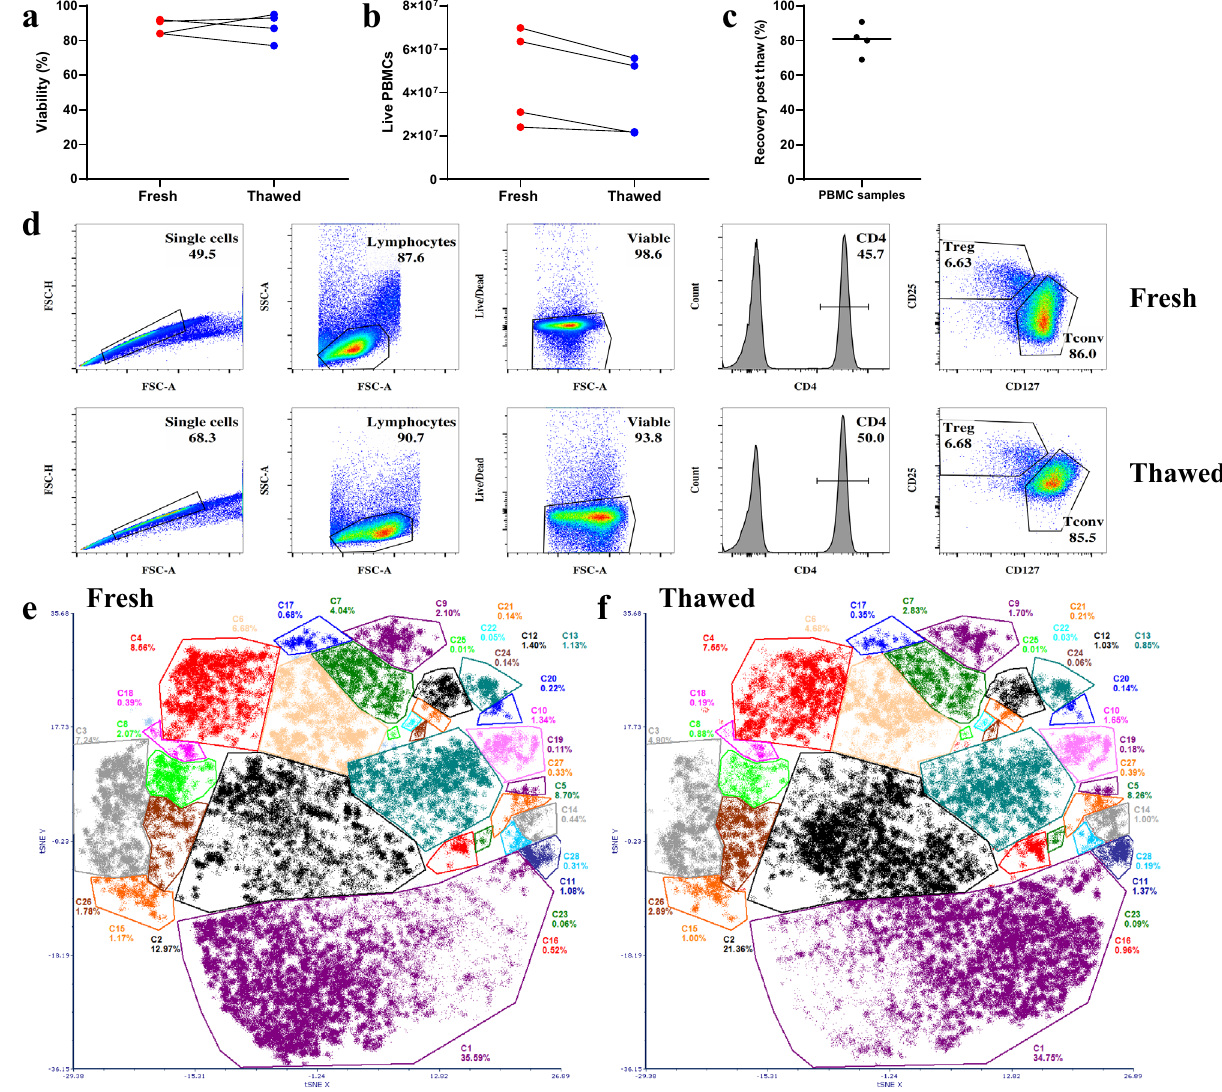
Figure 1. The complexity of frozen samples recapitulates that of the fresh samples. Viability ( a ) and absolute cell count ( b ) of the fresh and thawed PBMC samples. ( c ) Recovery (%) of live PBMC recovery after thawing. The cell viability and recovery of PBMC samples were determined using trypan blue dye exclusion test. ( d ) Flow cytometric profile from a representative fresh and thawed PBMCs sample and the gating strategy to isolate Conventional T (Tconv) and Regulatory T (Treg) cells. ( e – f ) Colour dot plots showing events from fresh ( e ) and thawed ( f ) CD4 positive cells contributing to t-SNE (t-distributed stochastic neighbour embedding) distribution with manual